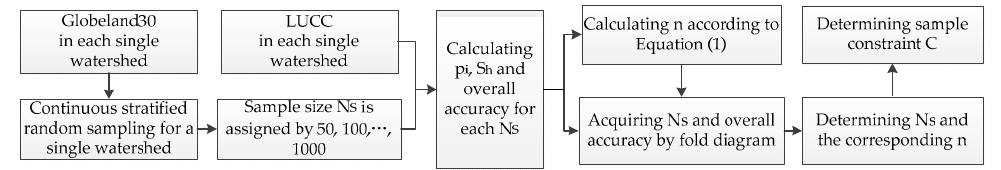
Figure 5. Flowchart of determining N S , n , and C.